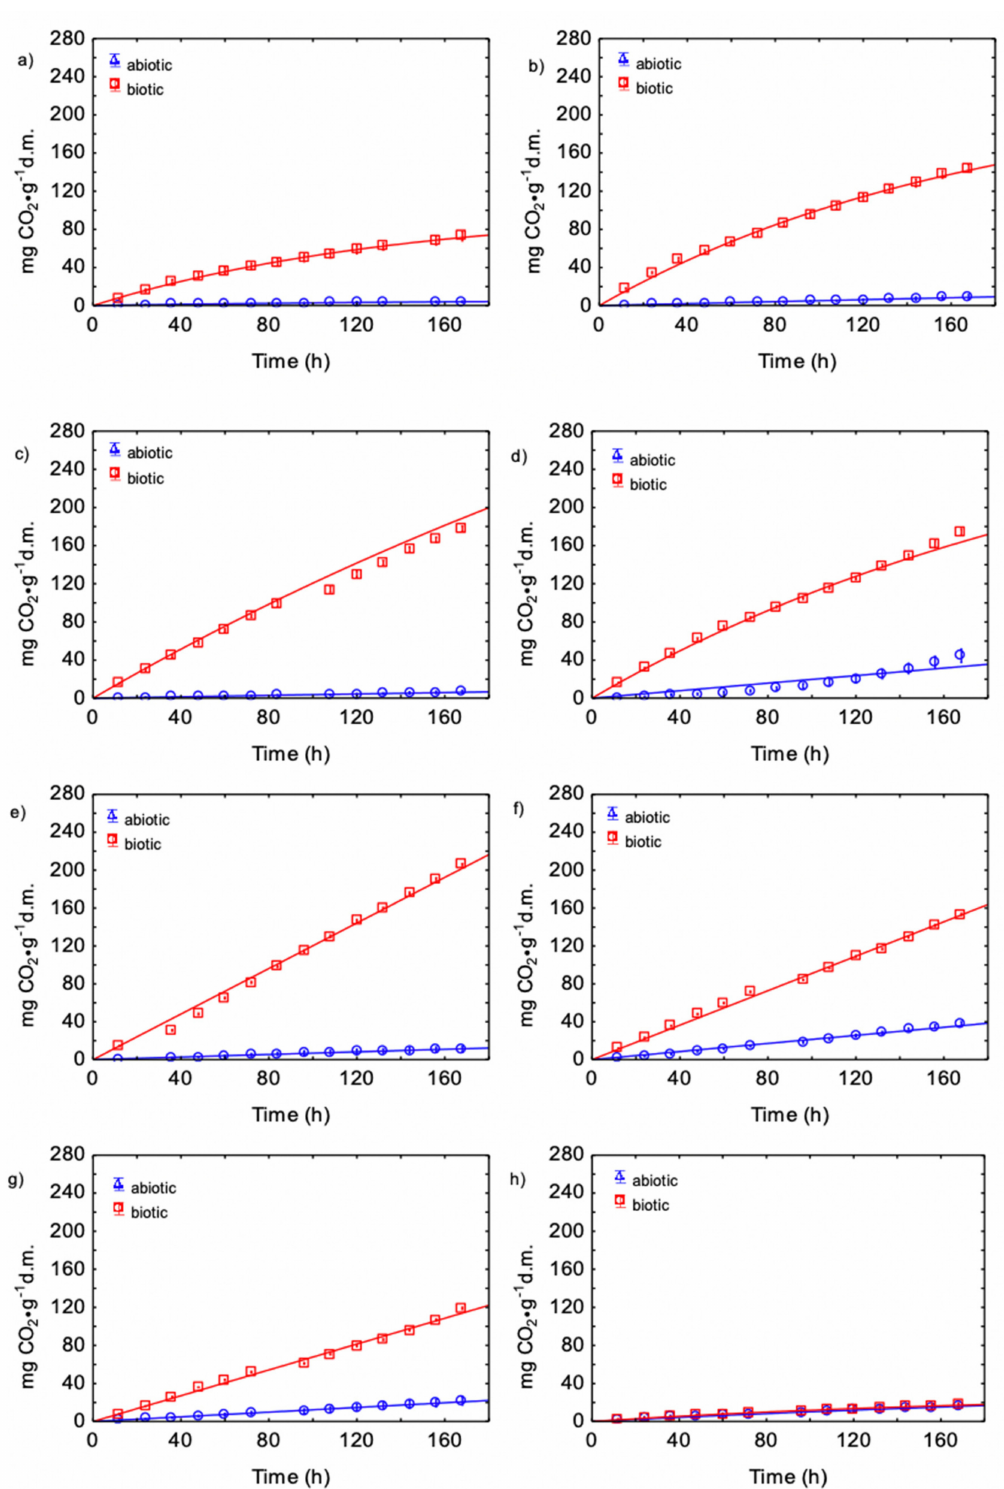
Figure 5. Cumulative CO 2 production depending on the temperature under abiotic and biotic conditions under di ff erent fixed temperatures ( a ) 10 ◦ C, ( b ) 20 ◦ C, ( c ) 30 ◦ C, ( d ) 37 ◦ C, ( e ) 40 ◦ C, ( f ) 50 ◦ C, ( g ) 60 ◦ C, ( h ) 70 ◦ C. The error bars are showing +/ − standard deviation around the mean. Raw data are shown in Tables S1.3 and S1.4 (Supplementary Materials, sheet 2). The kinetic values are shown in Table S2.2 (Supplementary Materials, sheet 5). Equations used in figures are shown in Table A1. The Tukey test p < 0.05 are shown in Tables S3.29–S3.56 (Supplementary Materials, sheet